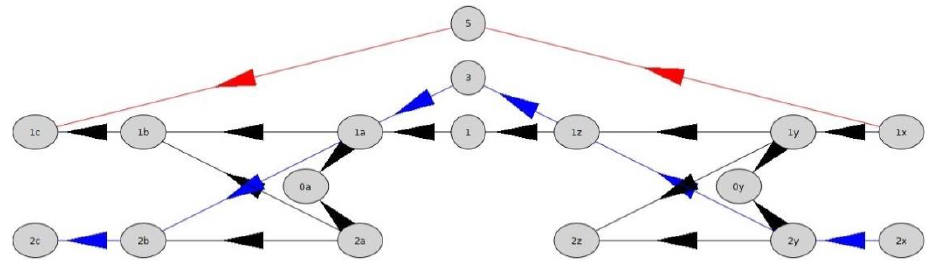
Figure 17. Two disjoint routes found in a degraded scenario.